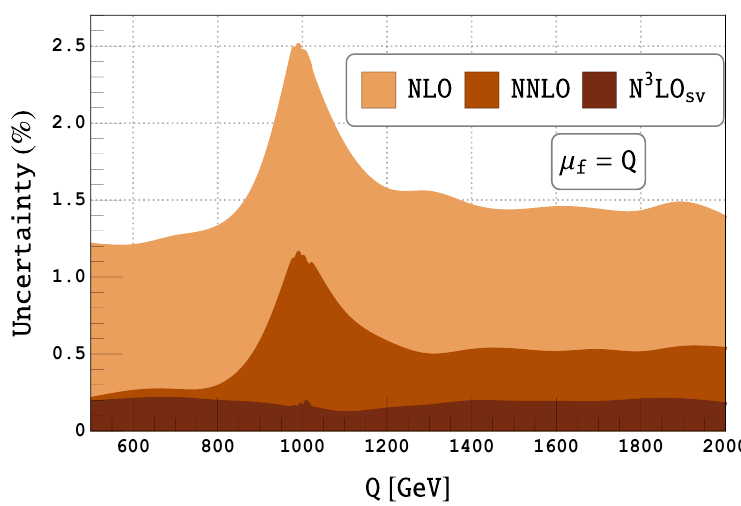
Figure 10 . The percentage of uncertainty in the signal due to µ r scale variation around the central scale Q (in the range µ r ∈ (1 / 2 , 2) Q ) at N 3 LO SV for fixed µ f = Q .